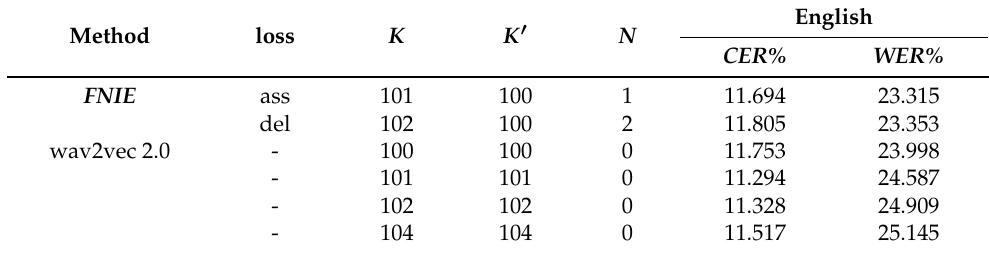
Table 4. Comparison of different numbers of negative